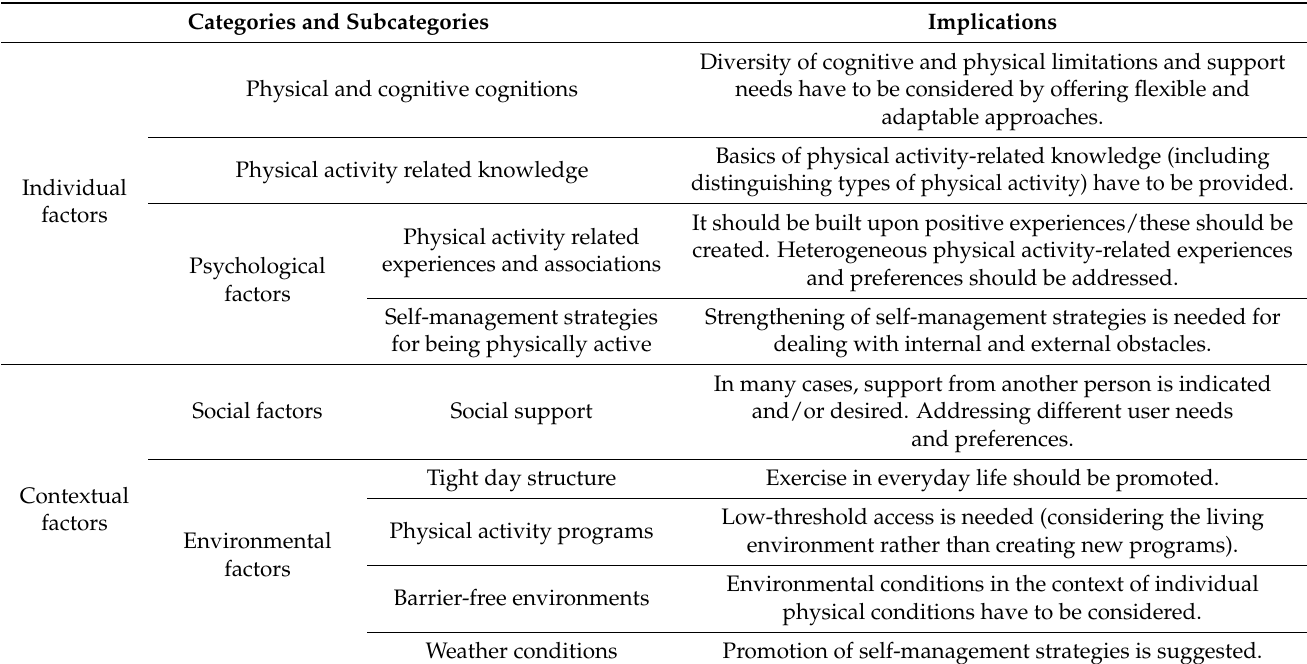
Table 2. Overview of individual and environmental factors influencing physical activity behavior, and implications for the development of physical activity-promoting